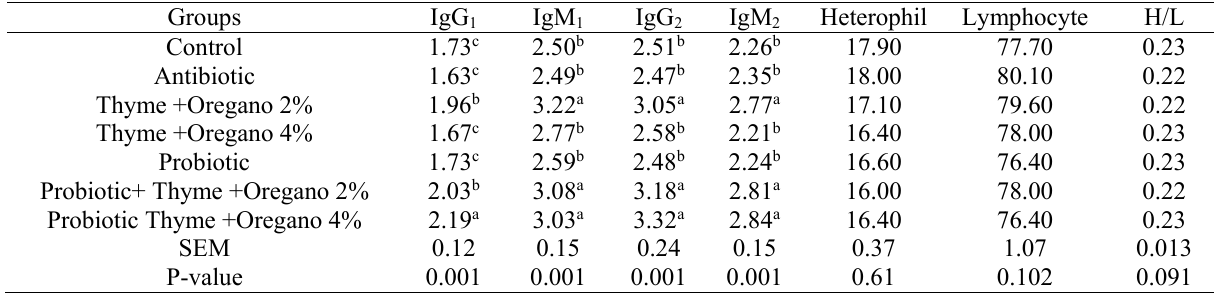
The effects of treatments on some humeral immunity parameters of broiler chicks